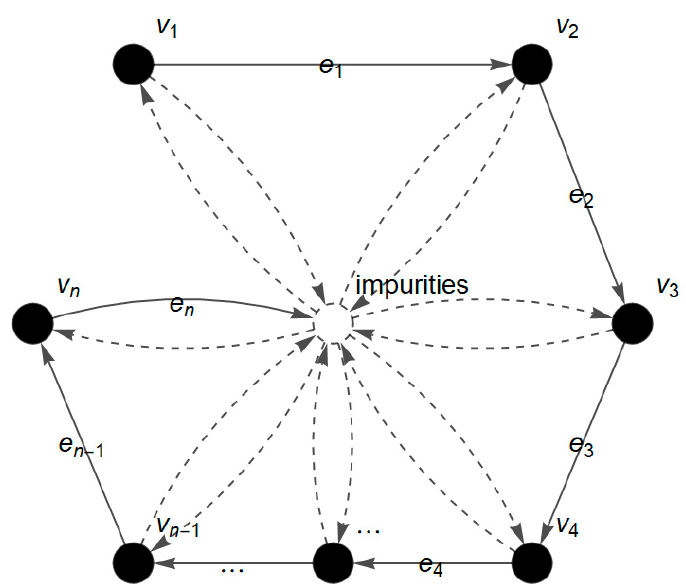
Figure 1. The FACS graph model of FTIR.